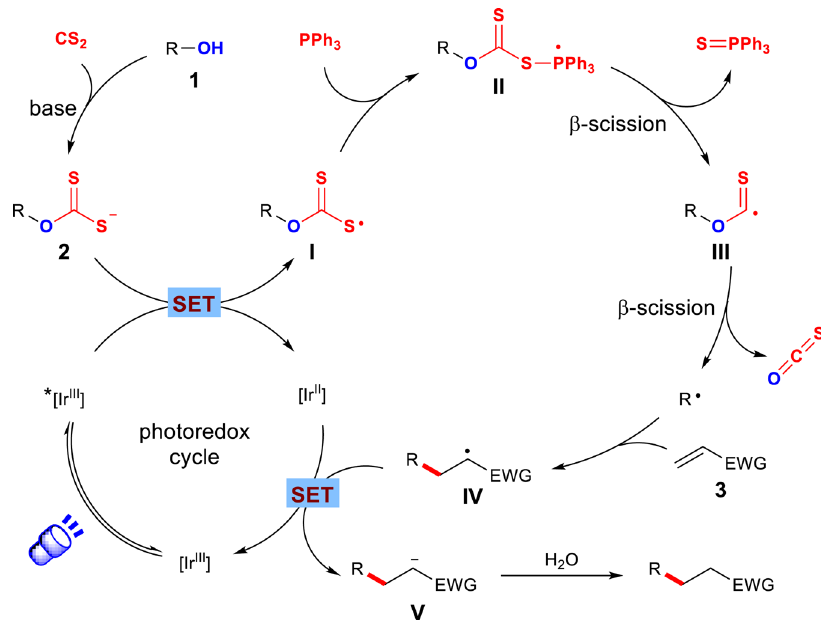
Fig. 8 Proposed reaction mechanism. SET single-electron transfer, [Ir] [Ir(ppy) 2 dtbbpy](PF 6